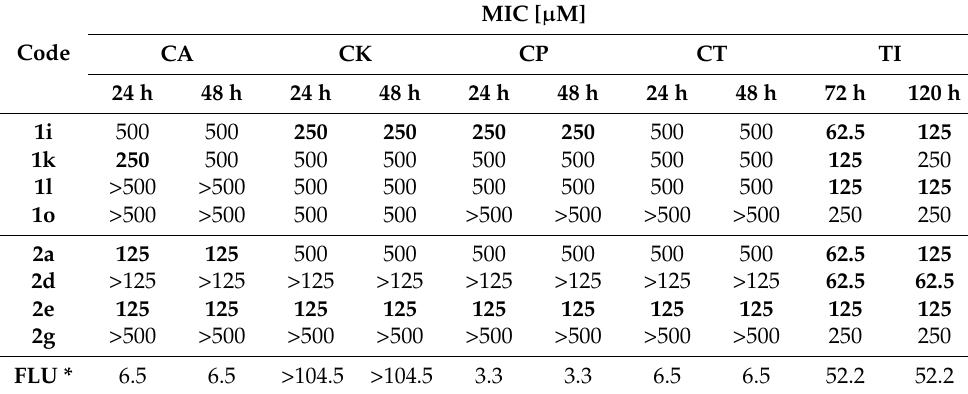
Table 2. Antifungal activity of 1 – 3